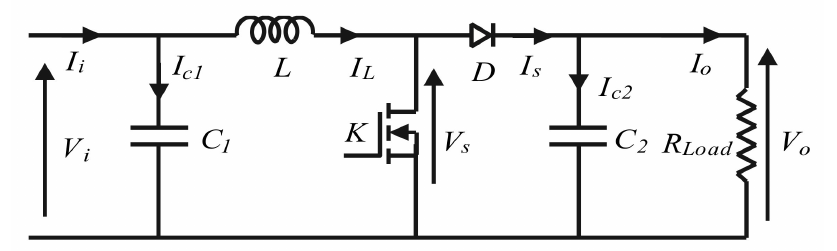
Figure 4. Schematic of the DC-DC boost